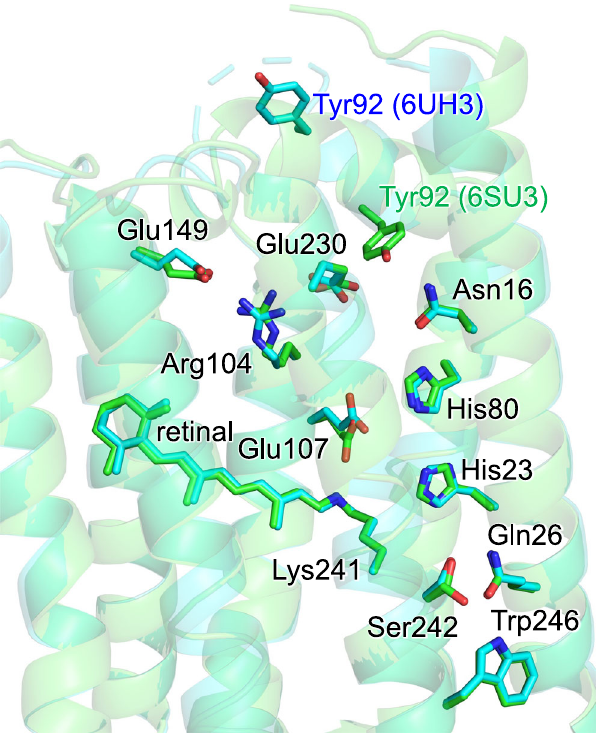
Fig. 10 Comparison of two crystal structures of heliorhodopsin 48C12. Root-mean-square deviation: 1.96 Å. Green sticks: PDB ID 6SU3 6 . Cyan sticks: PDB ID 6UH3 7